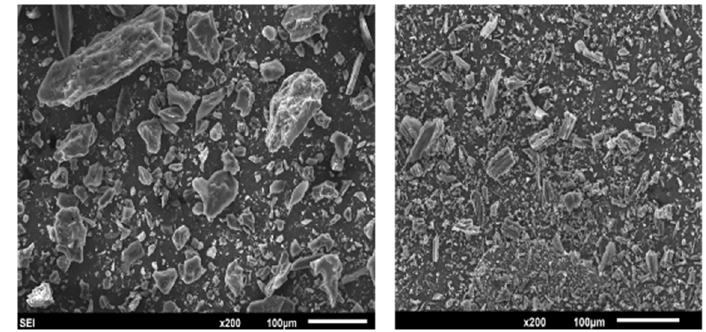
Chart 1. SEM images of HWOH (left) and WSCl2 (right).